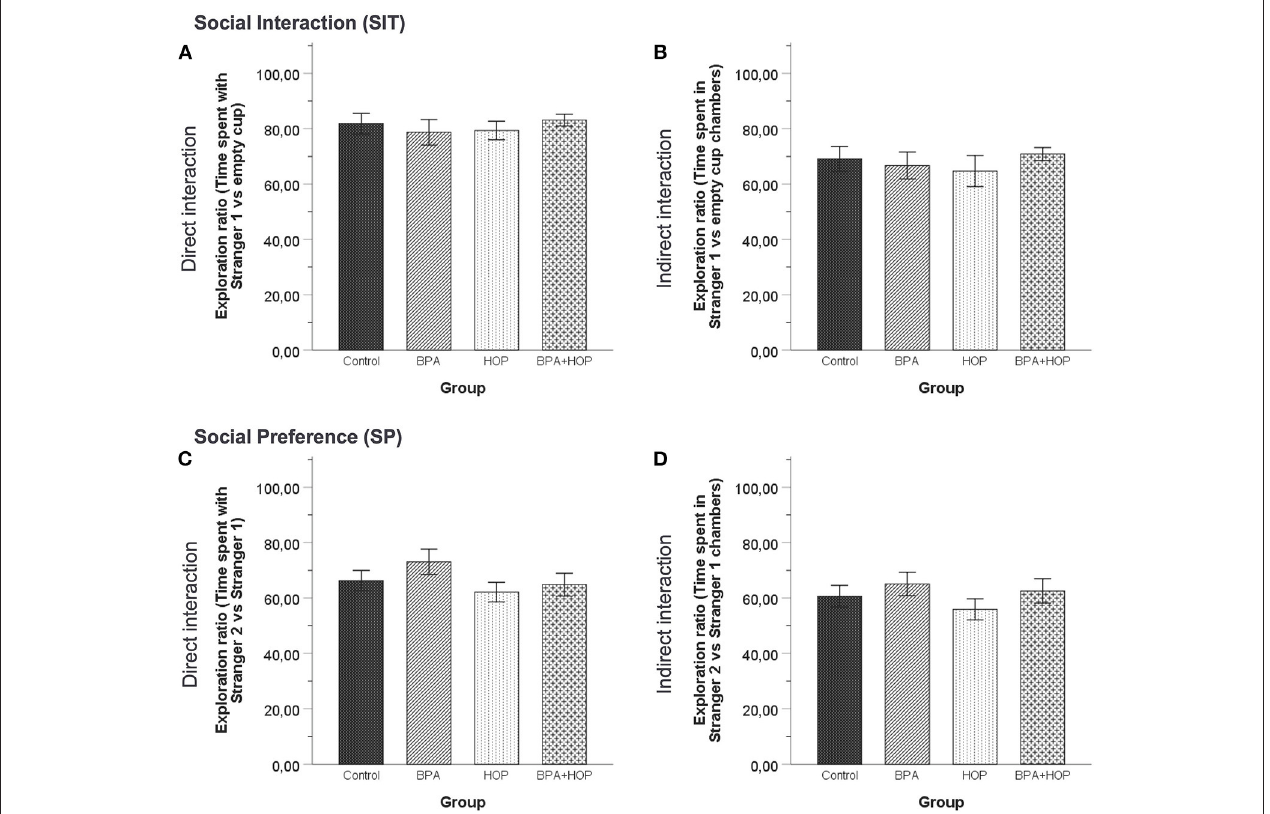
FIGURE 5 | All rats were tested in the social interaction test on PND 55 (Control: n = 10; BPA: n = 10; Hop: n = 11; BPA-Hop: n = 10). No significant differences in sociability as measured via the time spent directly interacting with the stranger rat vs. the empty cup (A) or indirectly interacting by being in the stranger rat’s chamber vs. the empty chamber (B) were noted. Social preference/recognition was also not altered, as measured via the time spent directly interacting with stranger rat 1 vs. stranger rat 2 (C) or indirectly interacting by being in the stranger rat 1’s chamber vs. stranger rat 2’s chamber (D) . Data are represented as mean ± SEM.